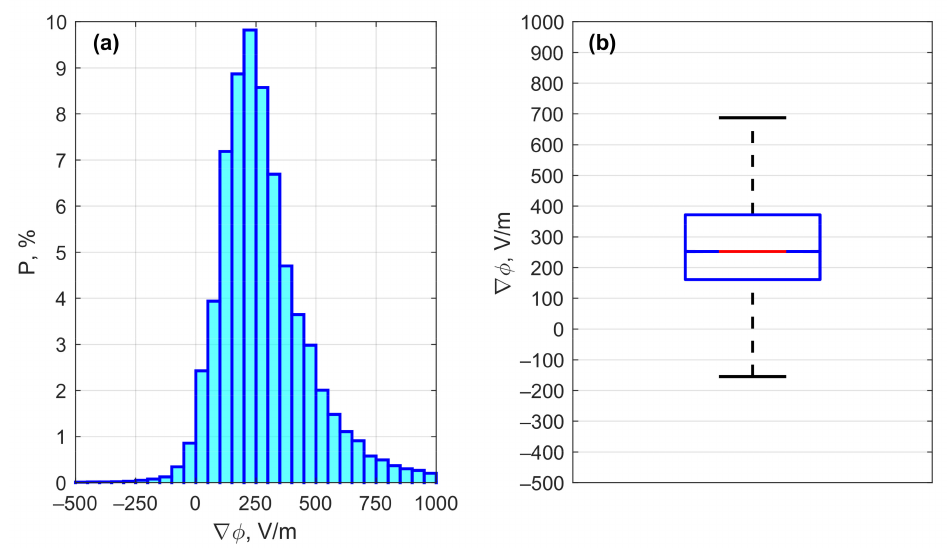
Figure 2. Histogram of the potential gradient under fair-weather conditions for 2006–2020 in Tomsk ( a ) and the box-plot quartile diagram ( b